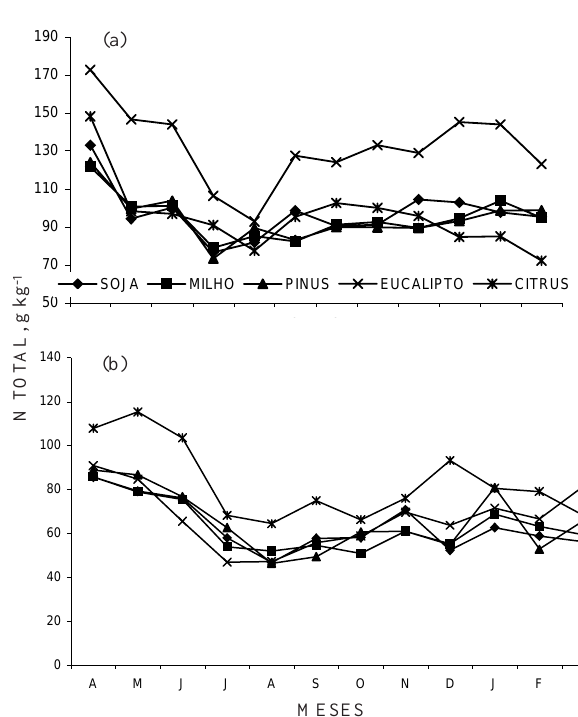
Figura 2. Nitrogênio total em amostras de LVaf (a) e LVd (b) cultivadas com soja, milho, pinus, eucalipto e citrus, em função do tempo de